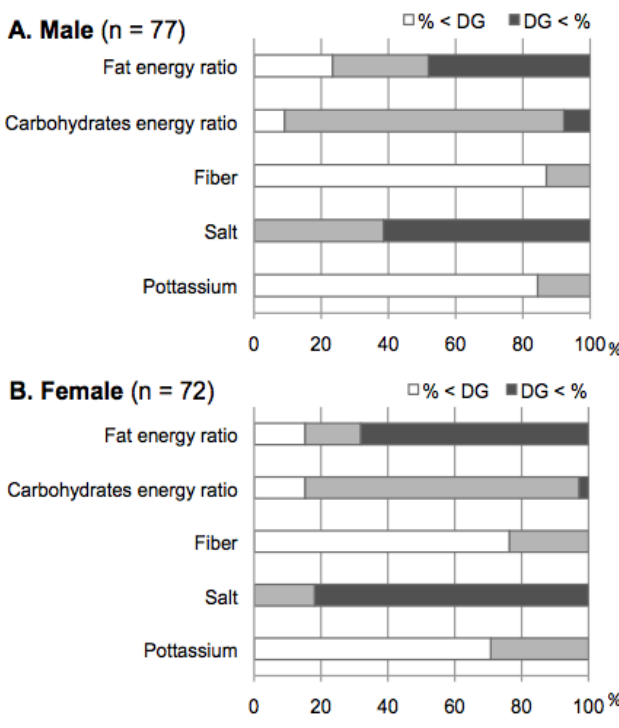
Figure 2. Assessment of the nutrient intake using the tentative dietary goal for preventing life-style related diseases (DG) within the Dietary Reference Intakes (DRIs) for Japanese. The percentages for patients who showed intakes less and greater than the DG to the whole were presented for individual nutrients. For these calculations, the DG ranges for the age classes (40–49, 50–69, and over 70 years) of each patient were